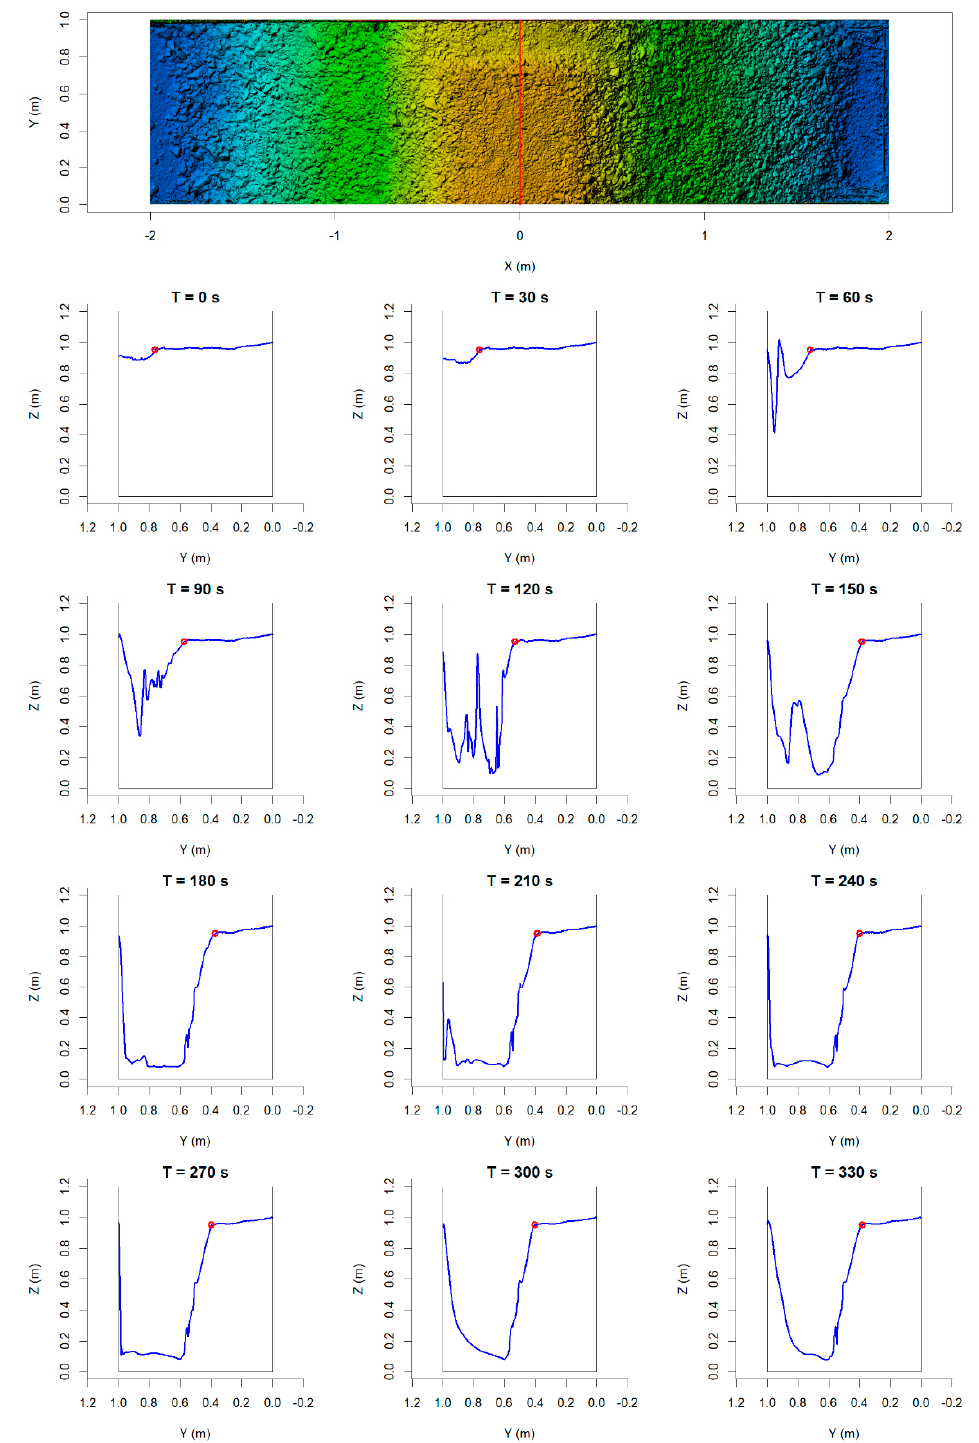
Figure A2. Cross-section profiles for X = 0 m (centre line) extracted from U2 dynamic 3D model; T = 0 s is immediately before initial observed erosion at downstream edge of crest; red circle indicates breach edge as used in further analyses.